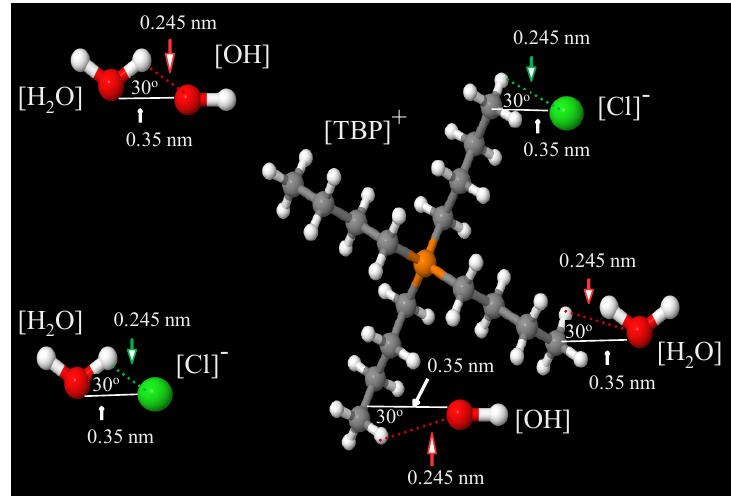
Figure 11. Geometric criteria for hydrogen bonds